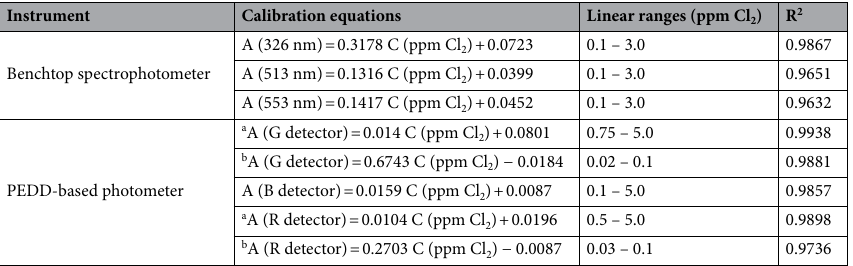
Table 1. A summary of the calibration curve equations and linear ranges obtained using the benchtop spectrophotometer and the developed PEDD-based photometer (conditions: 100 μL DPD reagent and 100 μL buffer solution of pH 6 were added to a total volume of 5.0 mL). For the PEDD-based photometer, the applied voltage was 2.5 V. a Higher concentration range. b Lower concentration